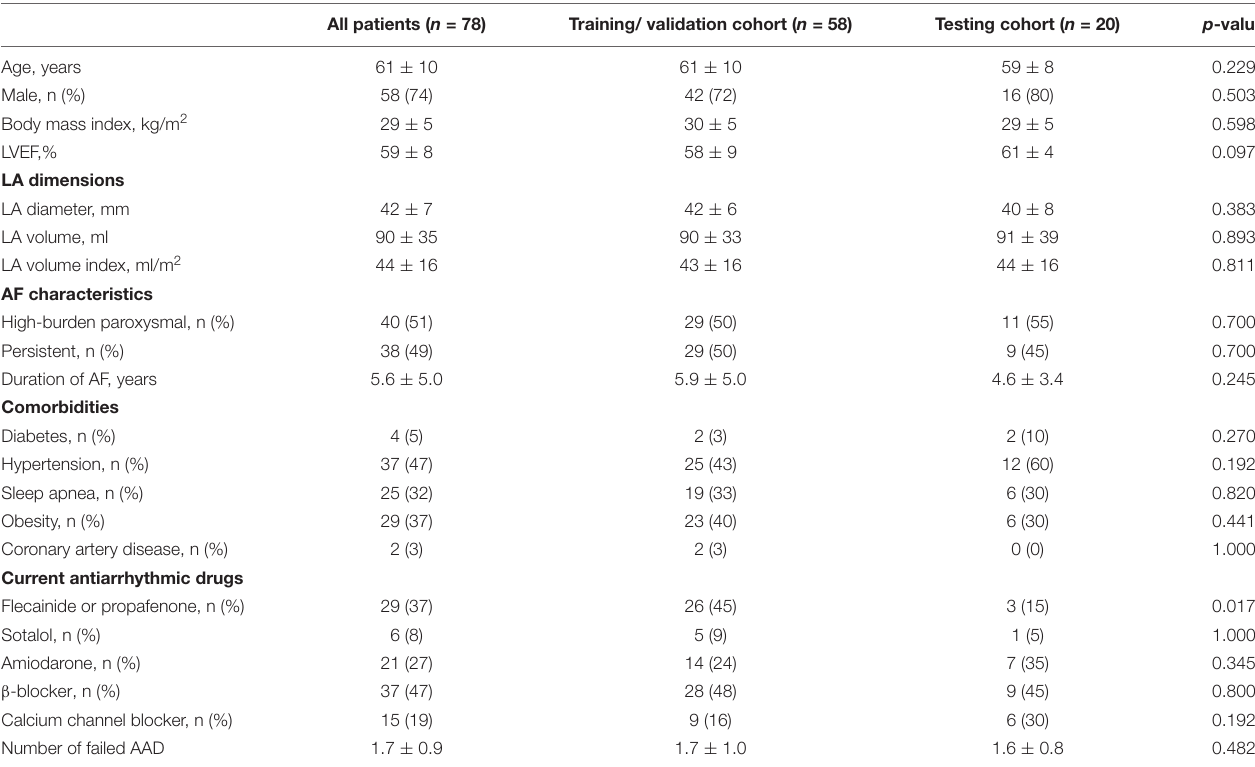
TABLE 1 | Baseline patient